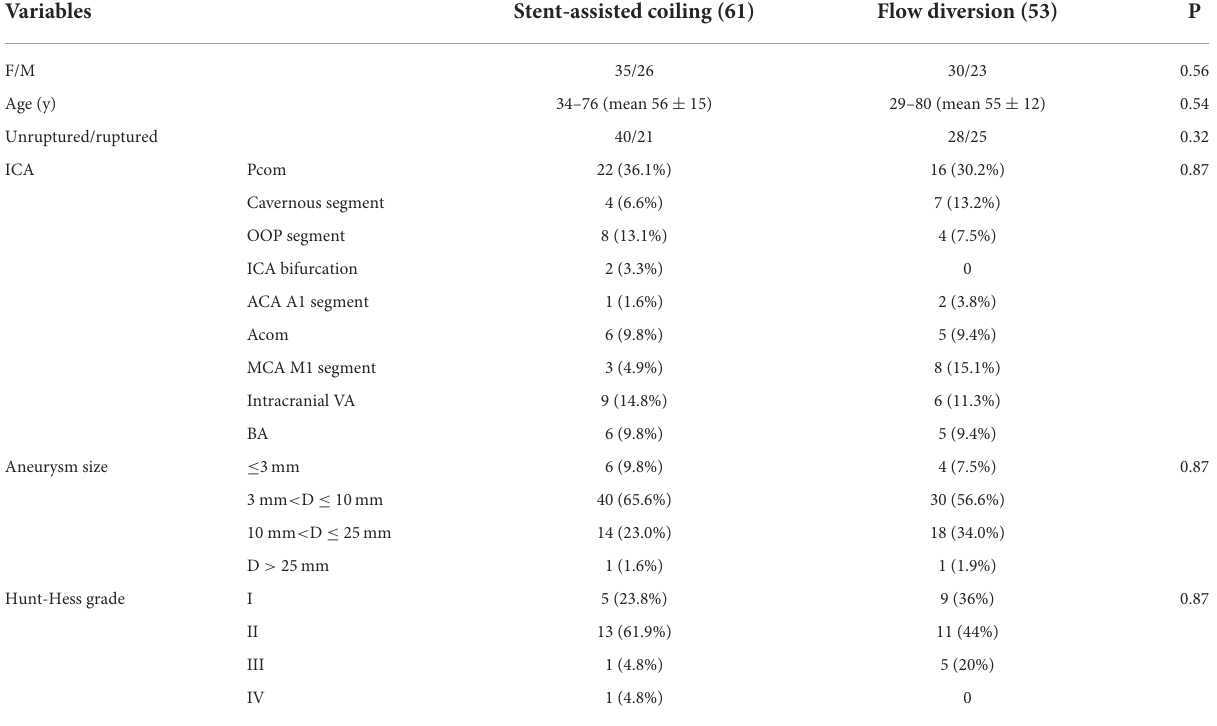
TABLE 1 Demography and treated aneurysms.